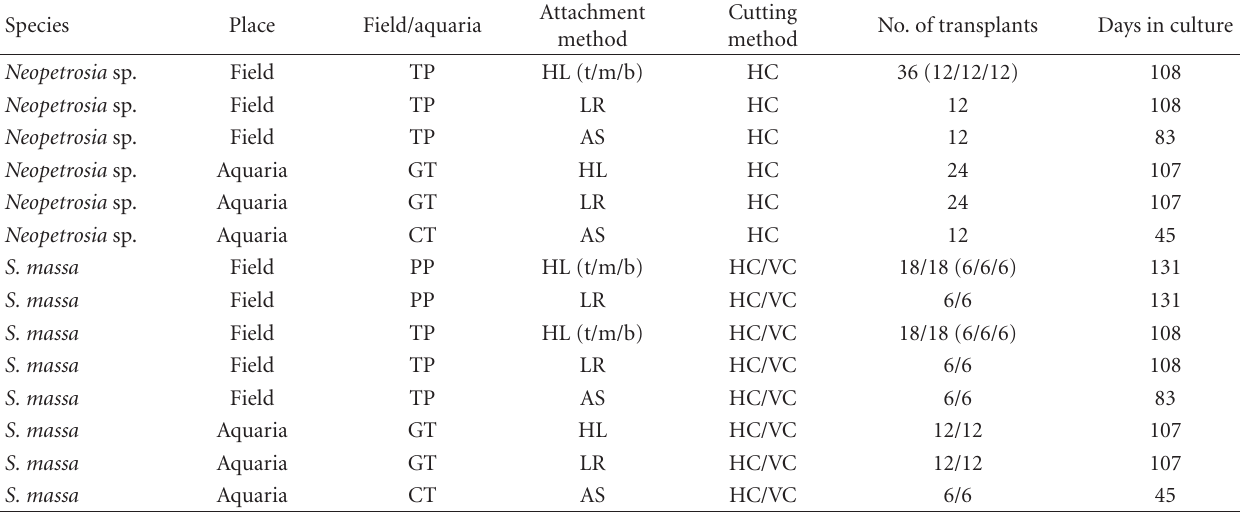
Table 1: List of application methods of fragments at the di ff erent study sites associated with the number of transplants and the days of culture.